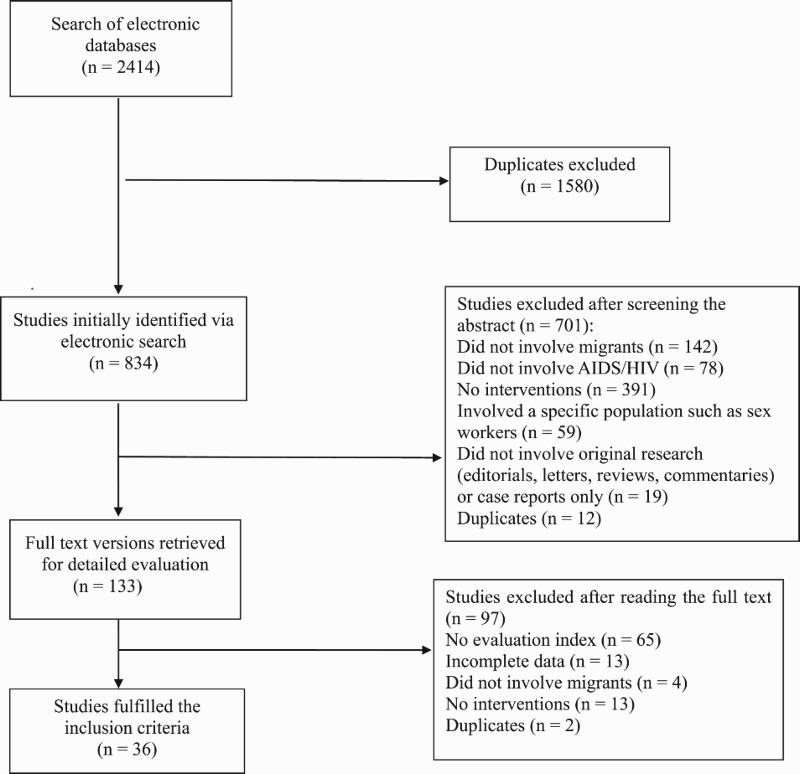
The QUOROM statement flowchart for study selection.